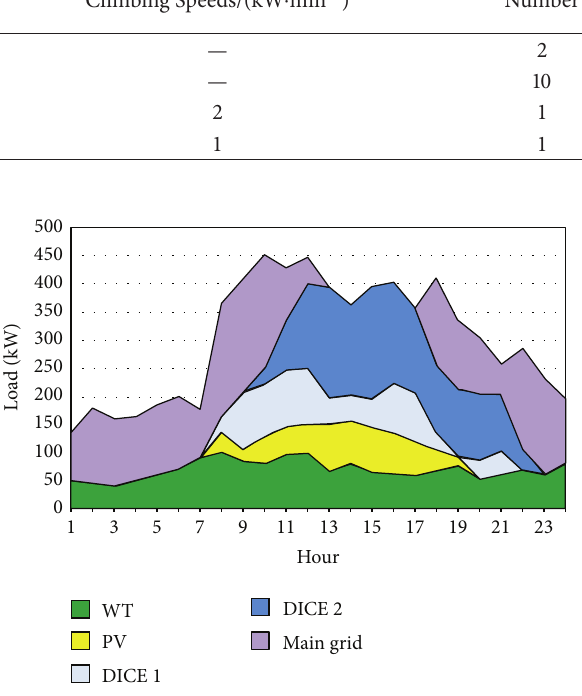
Figure 5: Environmental and economic dispatch